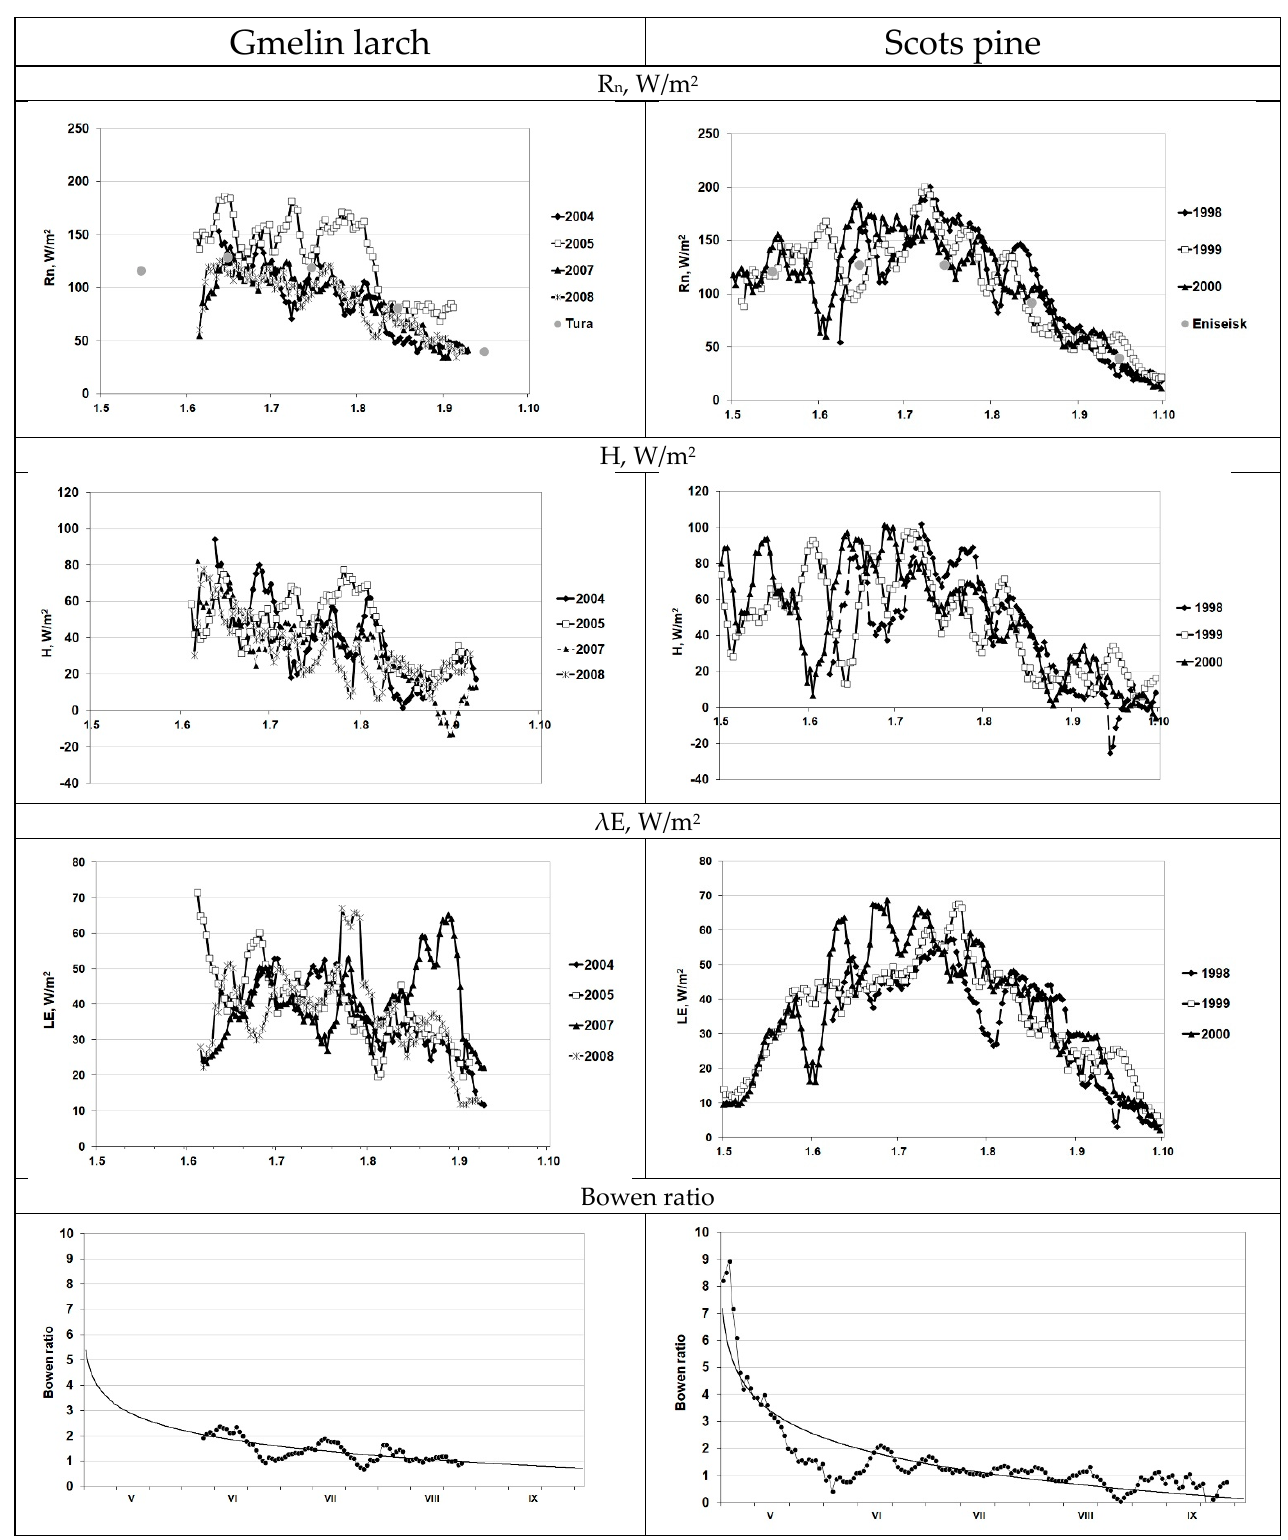
Figure 4. Energy balance components and Bowen ratio (positive 7-day running averages) in the Gmelin larch ( left ) and Scots pine ( right ) ecosystems for the growing season (May–September, V–IX): R n –Net radiation (filled dots are data from actinometric stations Tura (near the Gmelin larch forest) and Eniseisk (near the Scots pine forest); H—sensible heat, and λ E—Latent heat; Bowen